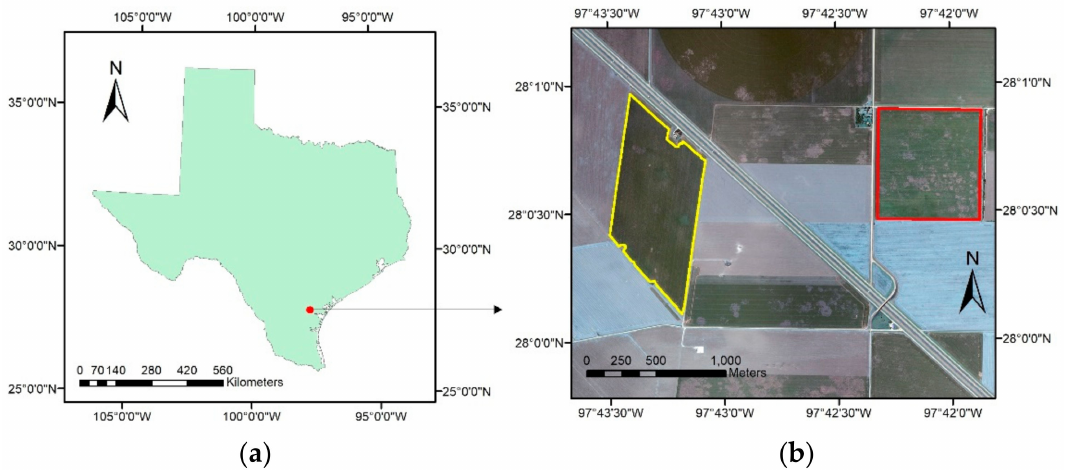
Figure 1. Location of the study area: ( a ) Texas; ( b ) experimental fields (Field A in yellow and Field B in